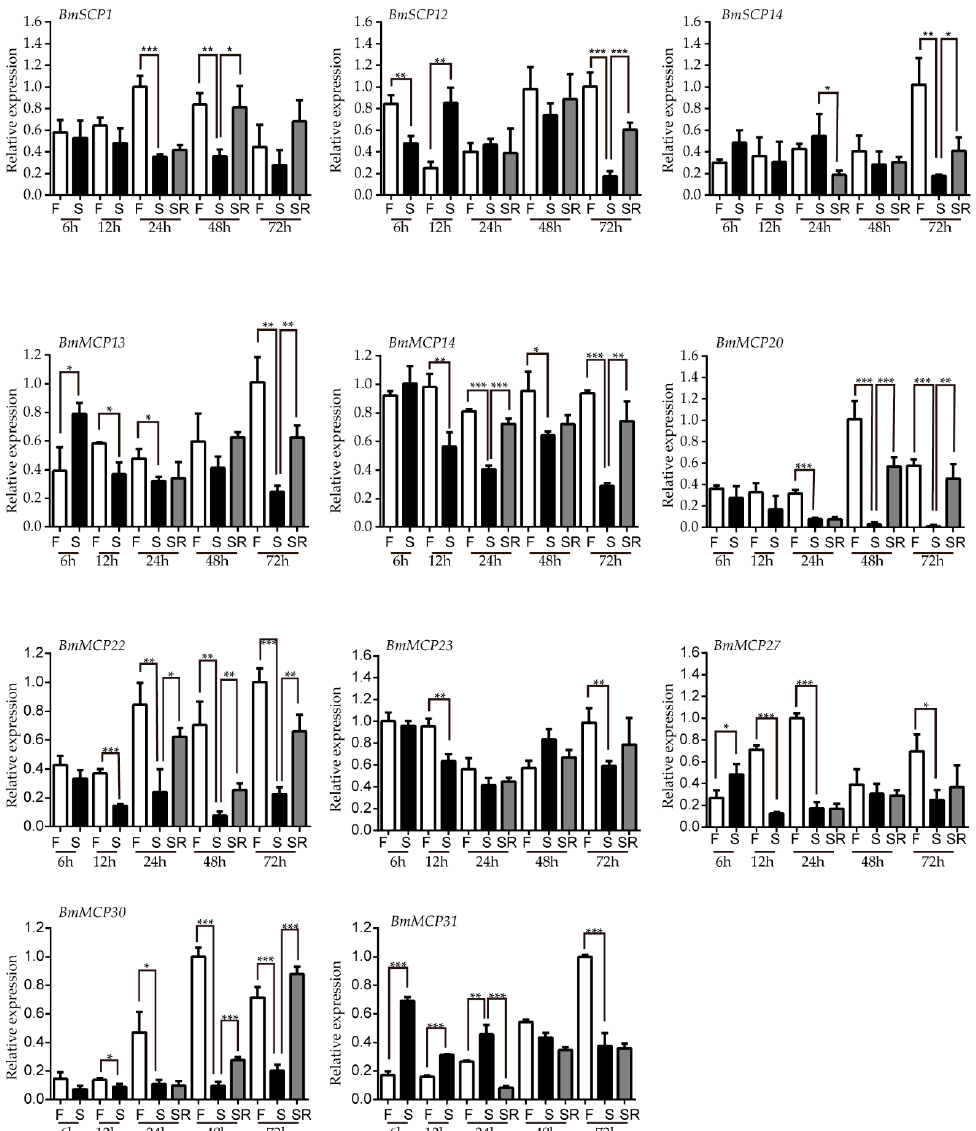
Figure 4. Expression patterns of midgut-specific carboxypeptidases after feeding, starvation and starvation-refeeding. Differences among groups were identified by Student’s t -test. * p < 0.05; ** p < 0.01; *** p < 0.001. Abbreviations: F, feeding; S, starvation; SR, starvation-refeeding.